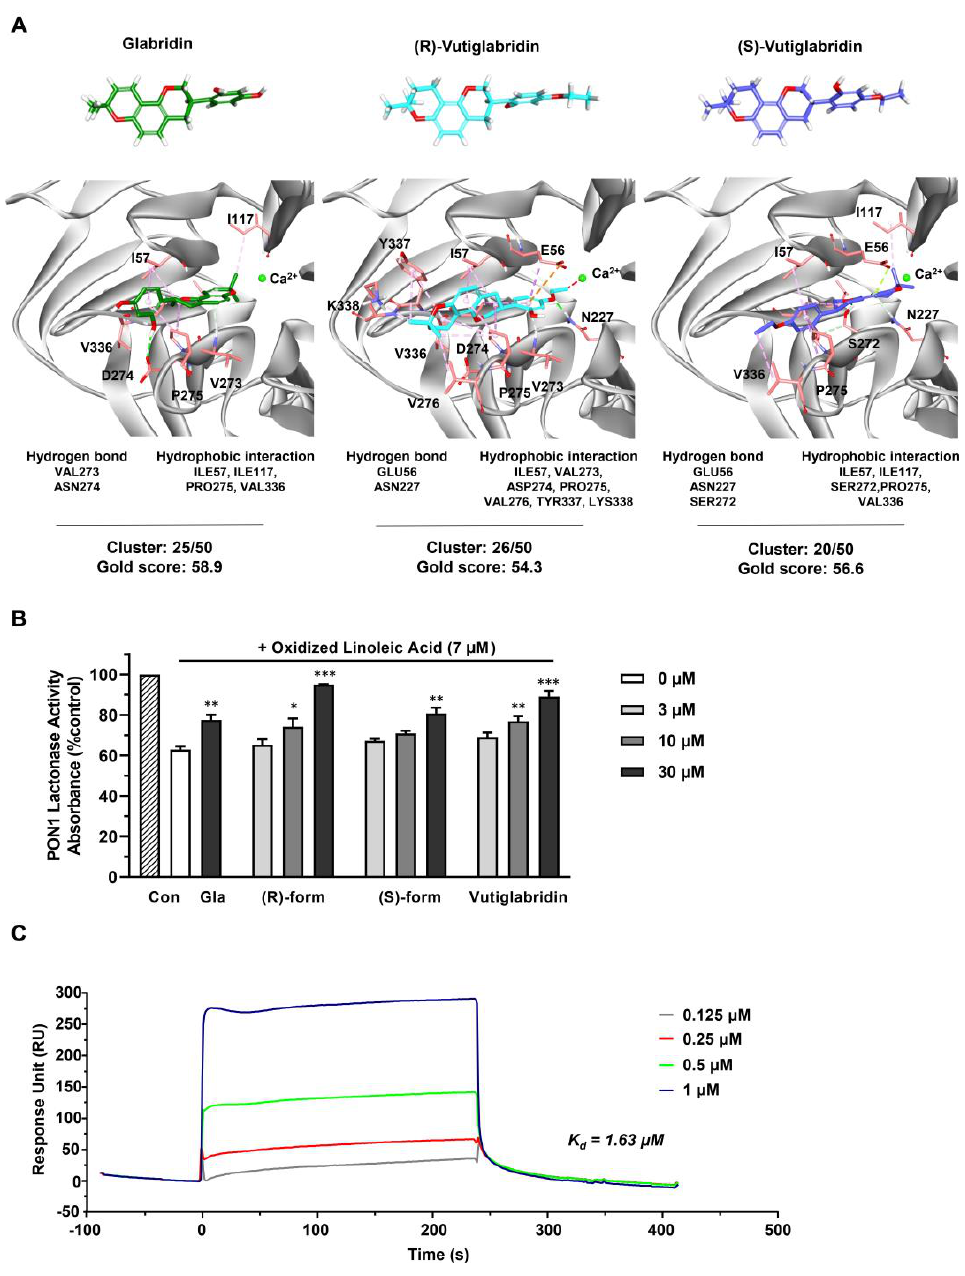
Figure 2. Vutiglabridin binds to rePON1 and increases it enzyme activity under oxidative stress conditions. ( A ) Chemical structures of glabridin, (R)-vutiglabridin, and (S)-vutiglabridin in stick model are shown in green, cyan, and purple, respectively. The oxygen and hydrogen atoms are in red and white, respectively. In the 3D structure of PON1 protein, the key residues of the binding site are represented by light red stick models. In the docked conformation of the three compounds, hydrogen bond, hydrophobic interaction, and unfavorable bump are shown as green, pink, and red dotted lines, respectively. The specific hydrogen bond and hydrophobic interaction sites, and the cluster analysis of compounds out of 50 trials and the GOLD fitness scores are written below each compound. ( B ) Glabridin (Gla), (R)-vutiglabridin, (S)-vutiglabridin, and vutiglabridin were incubated with